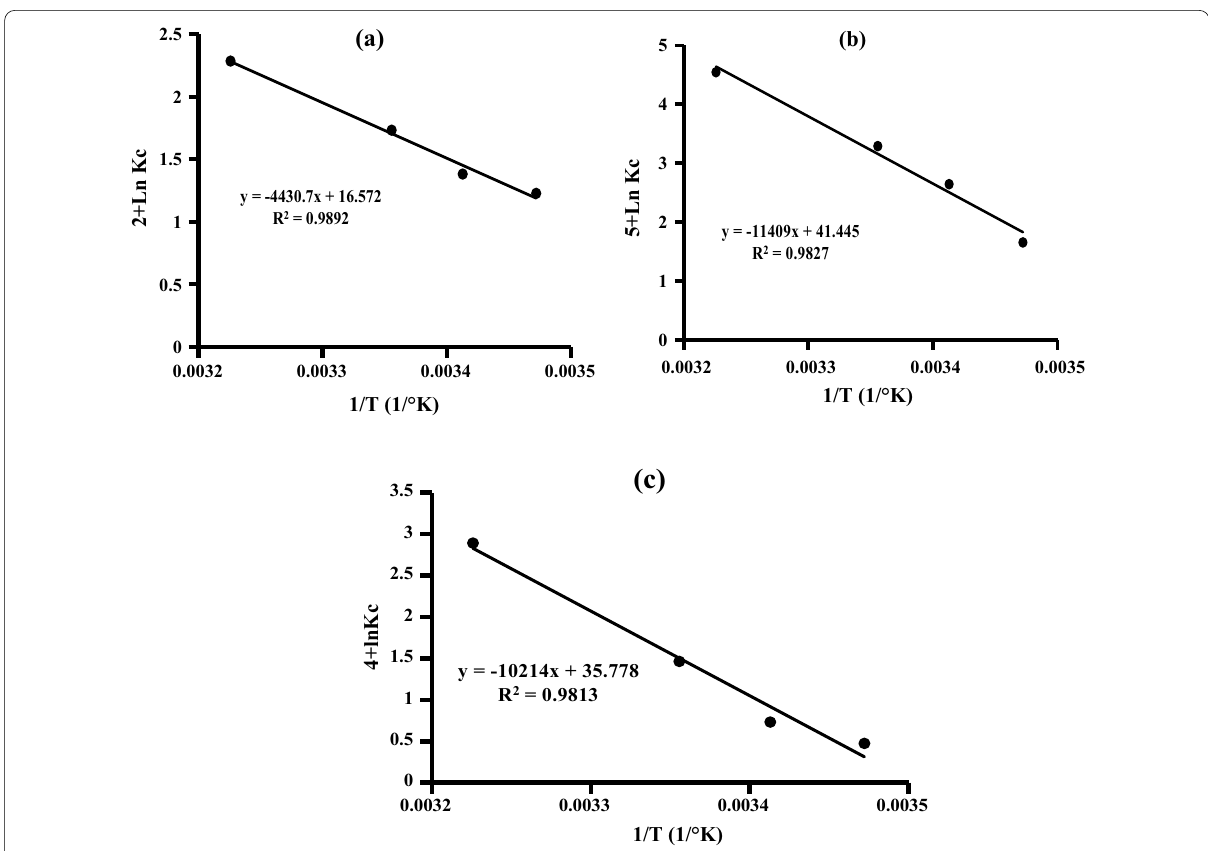
Fig. 9 Van’t Hoff plot for the adsorption of Hg 2 + on copolymer ( a ), aniline graft ( b ) and 2‑chloroniline graft ( c )